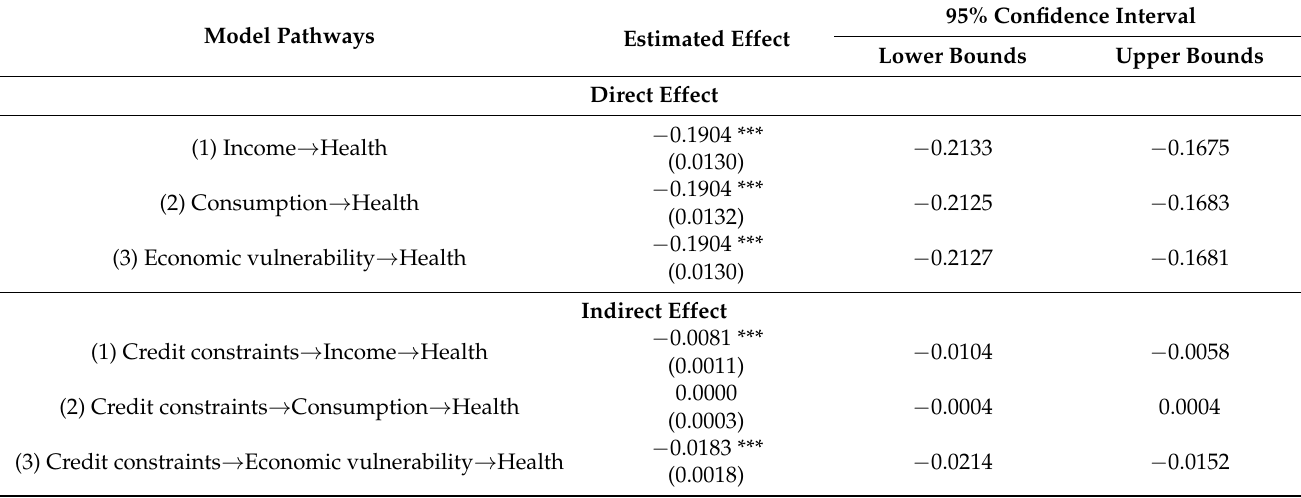
Table 7. Mediating effects of income, consumption, and economic vulnerability in the impact of formal credit constraints on rural residents’ self-rated